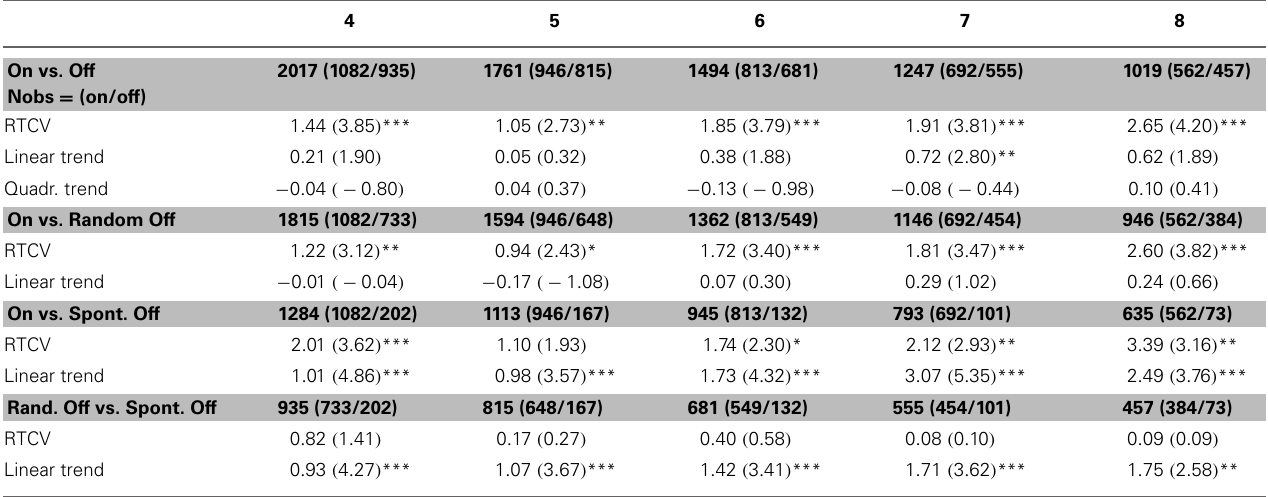
Table 1 | Contrasting the 4–8 trials preceding mind wandering and on-task